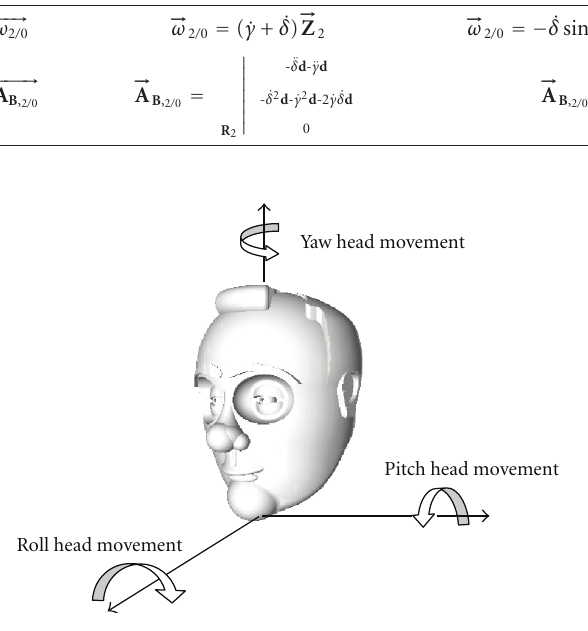
Figure 7: Definition of head movements: pitch, roll, and yaw. Euler angles which define the perpendicular of each canal −→ −→ −→ e a , e l , e p (anterior, lateral, and posterior, resp.), that plane is, their orientation in a 3D space relatively to the head